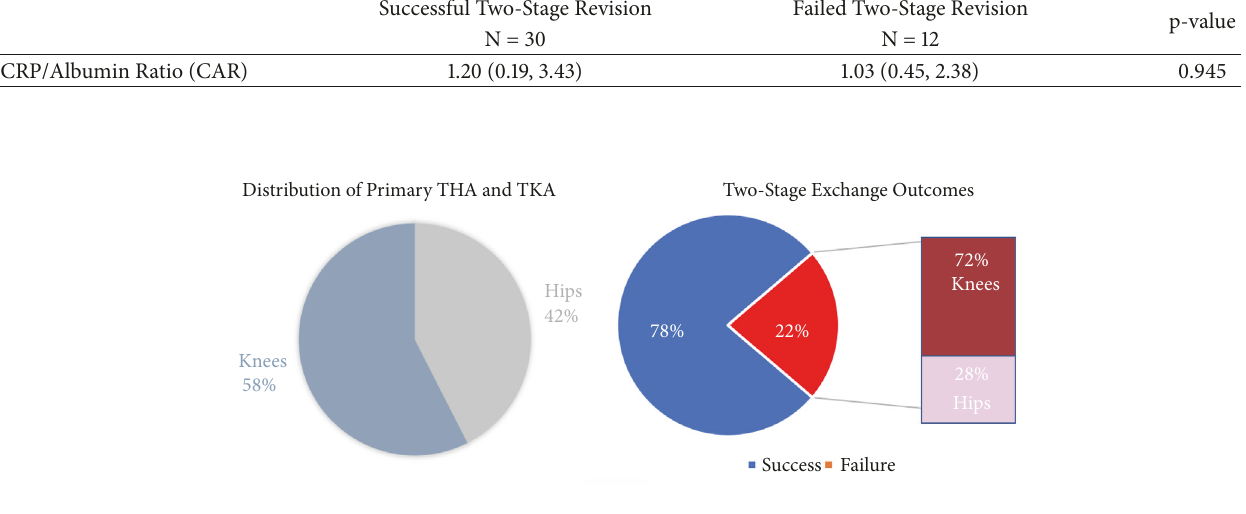
Figure 1: Left: distribution of patients included in study cohort. Right, distribution of two-stage exchange outcomes after primary THA and